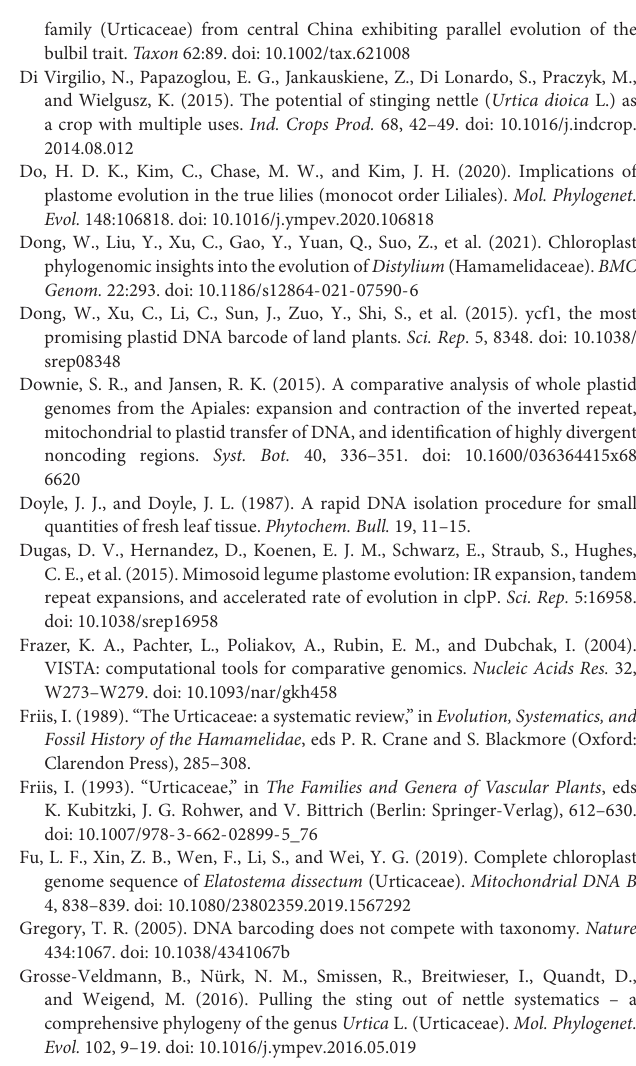
Supplementary Figure 3 | (A) Phylogenetic relationships of Urticeae tribe inferred from maximum likelihood (ML) and Bayesian inference (BI) based on CP coding (CDS) regions. Support values above the branches are maximum likelihood bootstrap support values (ML_BS)/Bayesian posterior probabilities (BI_PP)—note: branches with no support values indicate both ML_BS ≥ 90 and BI_PP = 1.00—whereas “ ∗ ” indicate incongruence between ML and BI trees. Major clades of Urticeae s.l. are indicated on the right, respectively. CDS, chloroplast coding region. (B) Phylogenetic relationships of Urticeae tribe inferred from maximum likelihood (ML) and Bayesian inference (BI) based on CP non-coding (nCDS) regions. Support values above the branches are maximum likelihood bootstrap support (ML_BS)/Bayesian posterior probability (BI_PP)—note that branches with no support values indicate both ML_BS ≥ 90 and BI_PP = 1.00—whereas “ ∗ ” indicate incongruence between ML and BI trees. Major clades of Urticeae s.l. are indicated on the right, respectively. nCDS, chloroplast non-coding region. (C) Phylogenetic relationships of Urticeae tribe inferred from maximum likelihood (ML) and Bayesian inference (BI) based on integrated CP genome and nrDNA trees. Support values above the branches are maximum likelihood bootstrap support (ML_BS)/Bayesian posterior probability (BI_PP)—note that branches with no support values indicate both ML_BS ≥ 90 and BI_PP = 1.00—whereas “ ∗ ” indicate incongruence between ML and BI trees. Major clades of Urticeae s.l. are indicated on the right, respectively. CP, Complete chloroplast genome; nrDNA, nuclear ribosomal DNA